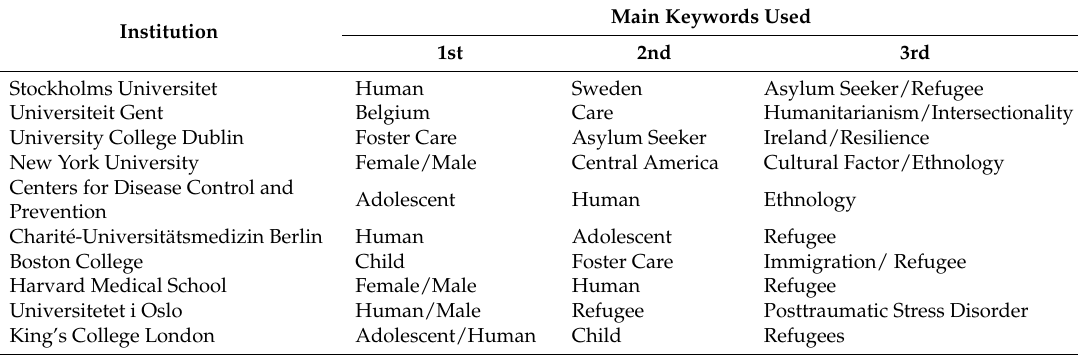
Table 4. Main affiliations and their most relevant keywords in the subject of unaccompanied